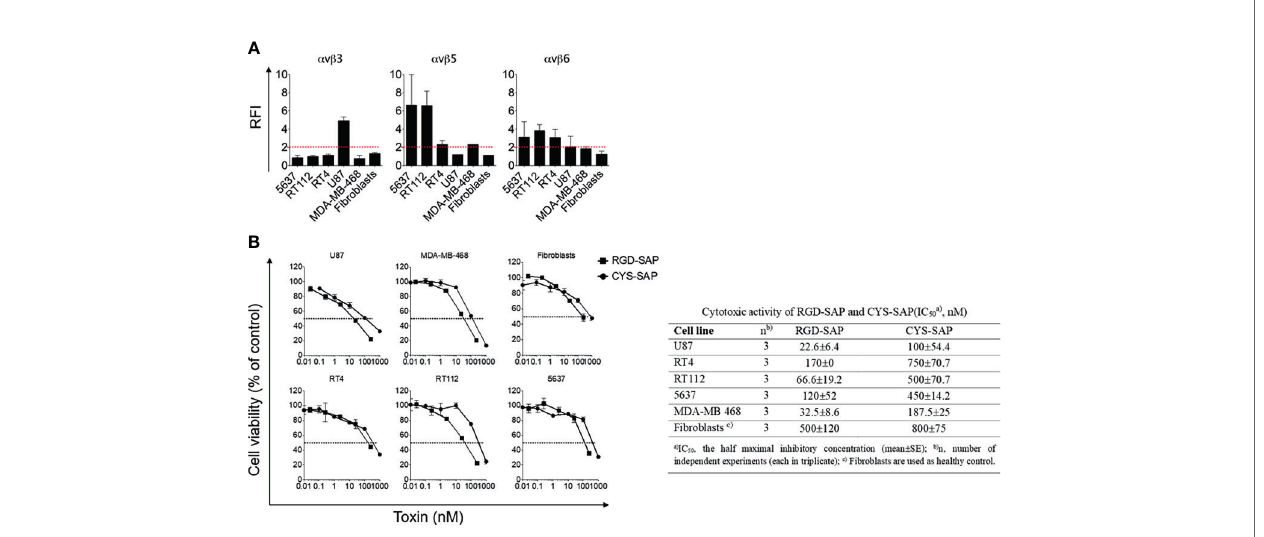
FIGURE 2 | Integrins expression on cancer cell lines and in vitro biological activity evaluation of RGD-SAP and CYS-SAP recombinant proteins. (A) 5637, RT112, RT4, U87, MDA-MB-468 cancer cell lines and fi broblasts were analyzed by fl ow cytometry for a v b 3, a v b 5 and a v b 6 integrins expression. Relative Fluorescence Intensity (RFI) are shown as mean±SD. The dashed red line represents the threshold arbitrarily de fi ning positive expression (RFI=2). (B) Effect of various amounts of RGD-SAP or CYS-SAP on the indicated cells as determined by MTT assay after 72 h treatment. One representative experiment out of three performed is shown. Cell viability is expressed as percentage to untreated cells (mean ± SD). The IC 50 from three different experiments is reported as mean ±